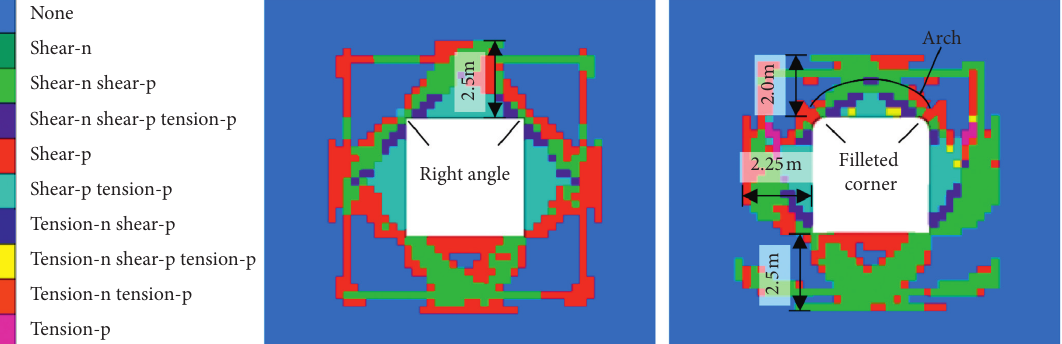
Figure 14: Comparison of the plastic zone of the roadway.